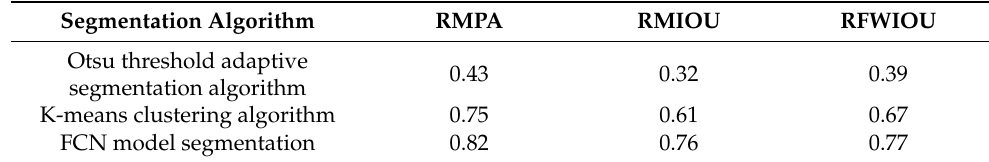
Table 2. Test results of three segmentation